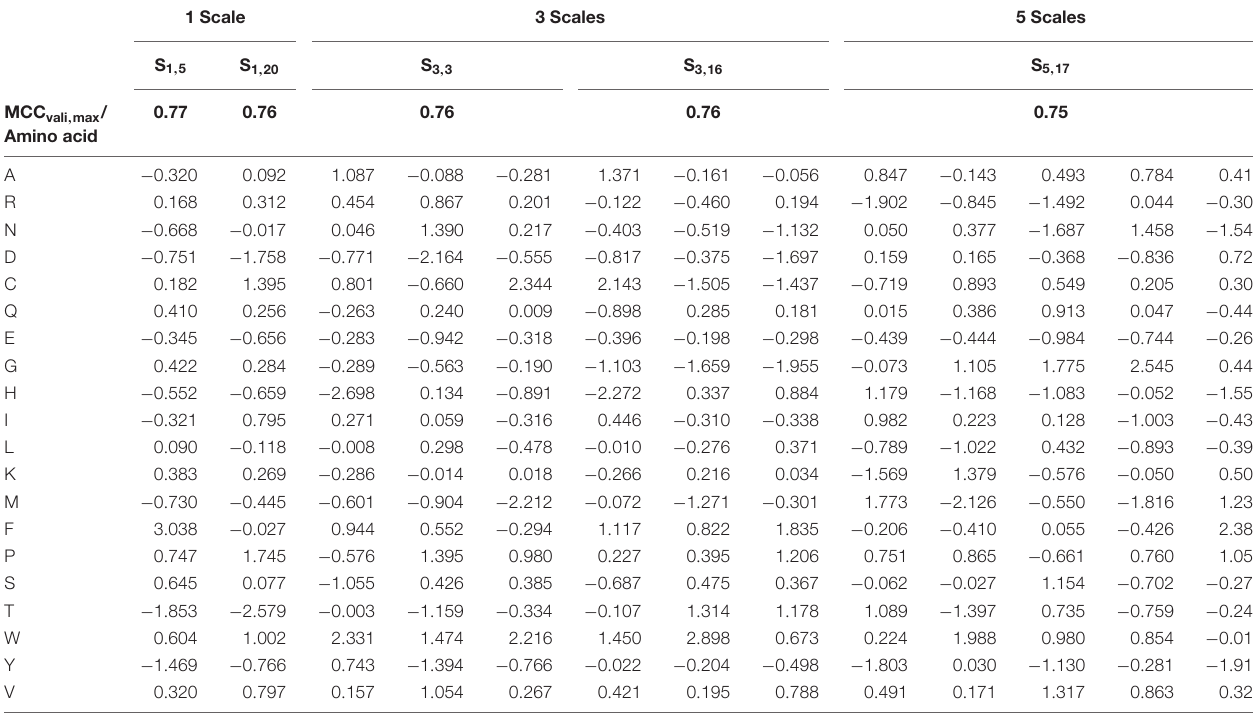
TABLE 3 | Best five scale tables, measured by highest test set Matthew’s Correlation Coefficient (MCC) at maximum validation